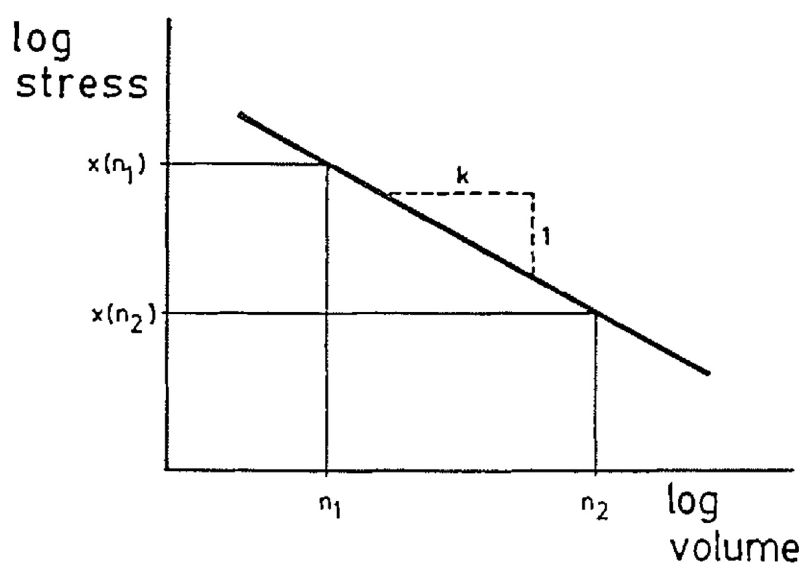
Figure 48. Schematic plot showing how the size effect parameter ‘g’ is calculated. From [86]. Table 2. Key to the specimen dimensions for which data are plotted in Figure 49. From [134].